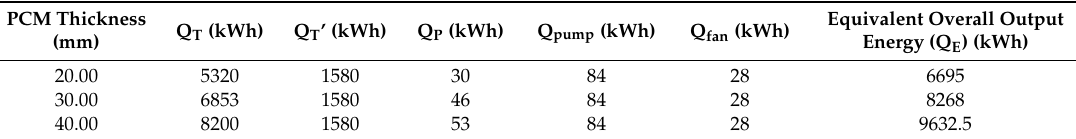
Table 7. Time − wise results of PCM thickness